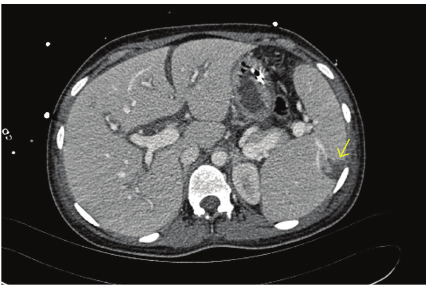
tissues of the perineum and pelvic floor as well as